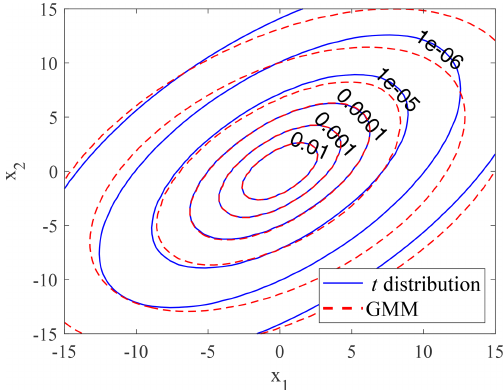
Figure 3. Contour plot of the t distribution and